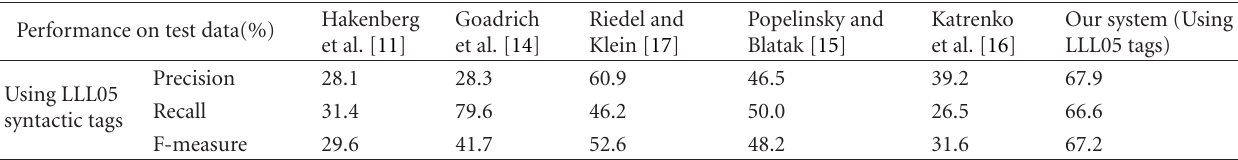
Table 3: Performances of our system and other previous systems using LLL05 syntactic tags.